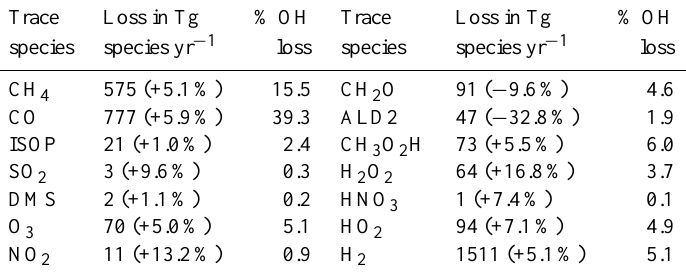
Table 6. Details regarding the total mass of each trace species (Tgyr − 1 ) oxidized per year in the MBA simulation. The percentage changes between the BA and MBA simulation are also given using the MBA/BA ratio.